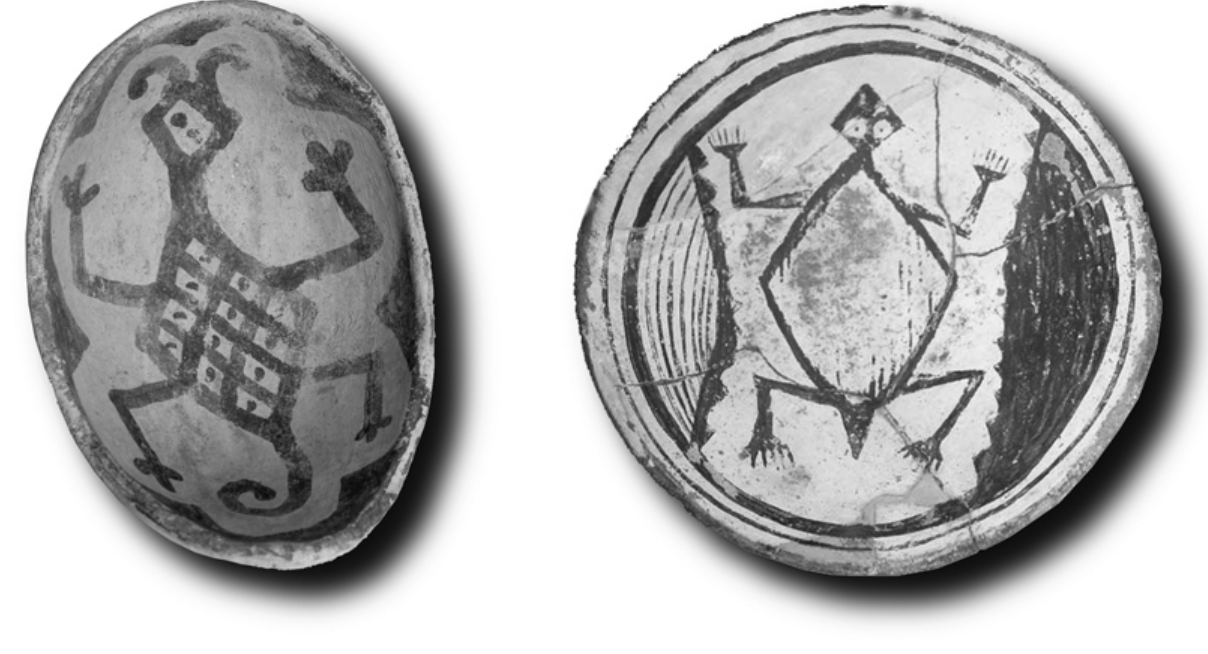
Fig. 4 . Hohokam (left) and early Mimbres (right) bowls with horned toad designs. Similarities include diamond-shaped heads and bodies, positions of limbs and digits, and triangular framing. Hohokam toad is from the Arizona State Museum and the Mimbres toad from the Amerind